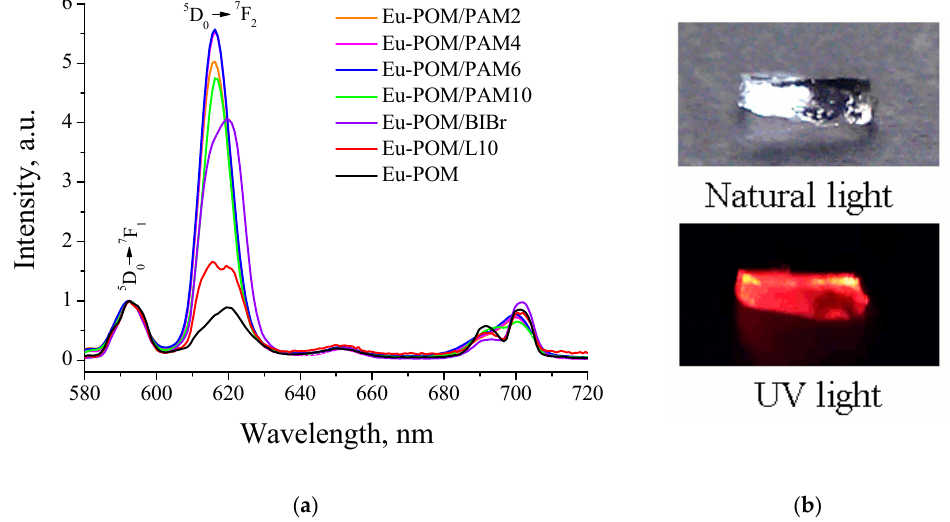
Figure 7. ( a ) Emission spectra for Eu-POM in different environments ( λ ex = 365 nm), ( b ) image of PAM10 hydrogel taken in natural and UV light.